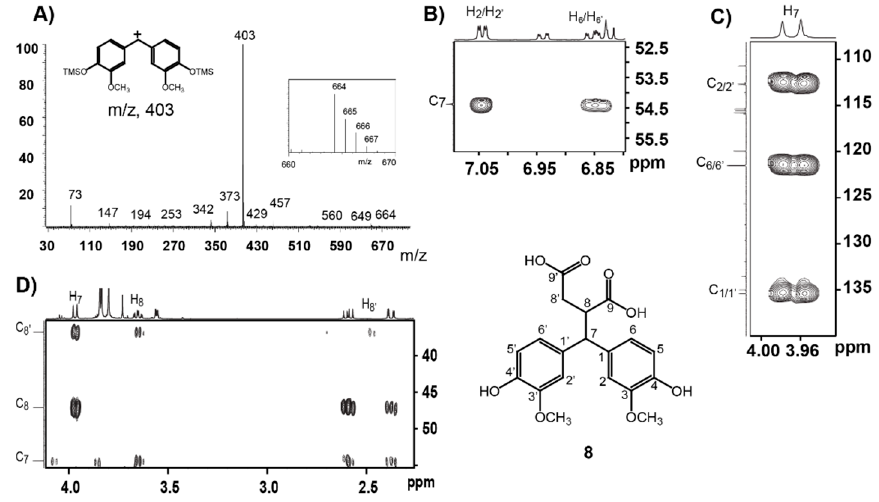
Figure 3. HMBC NMR ( B - D ) and mass spectra ( A ) of compound 8 , showing characteristic features to establish its chemical structure shown.